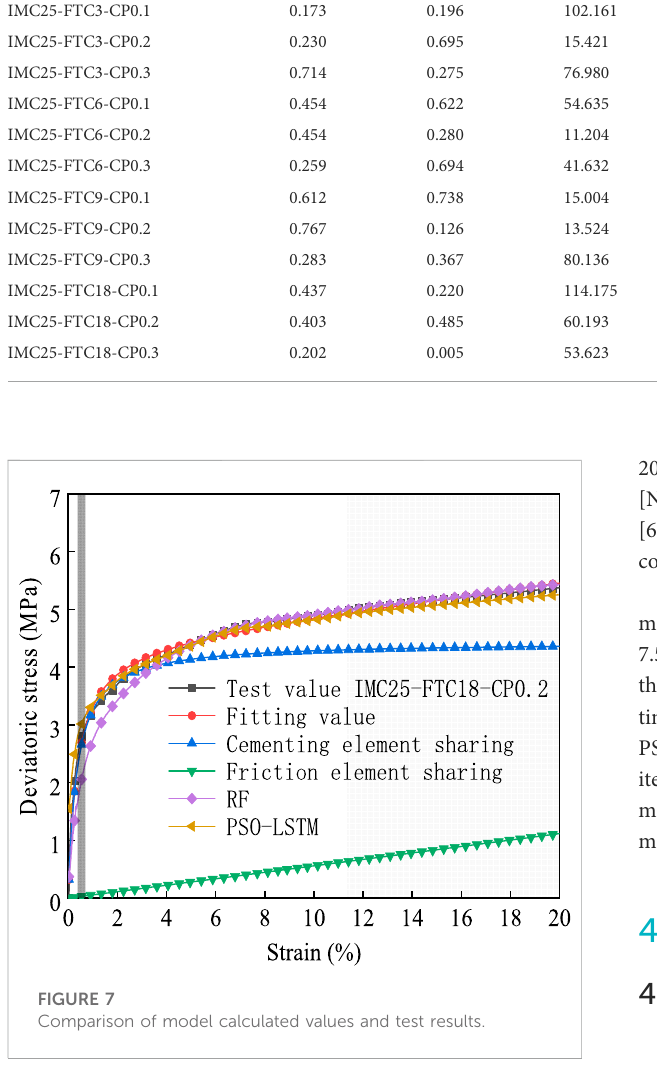
Figure 5 that freeze-thaw cycles and con fi ning pressure do not change the strain characteristics of frozen silty clay. With the